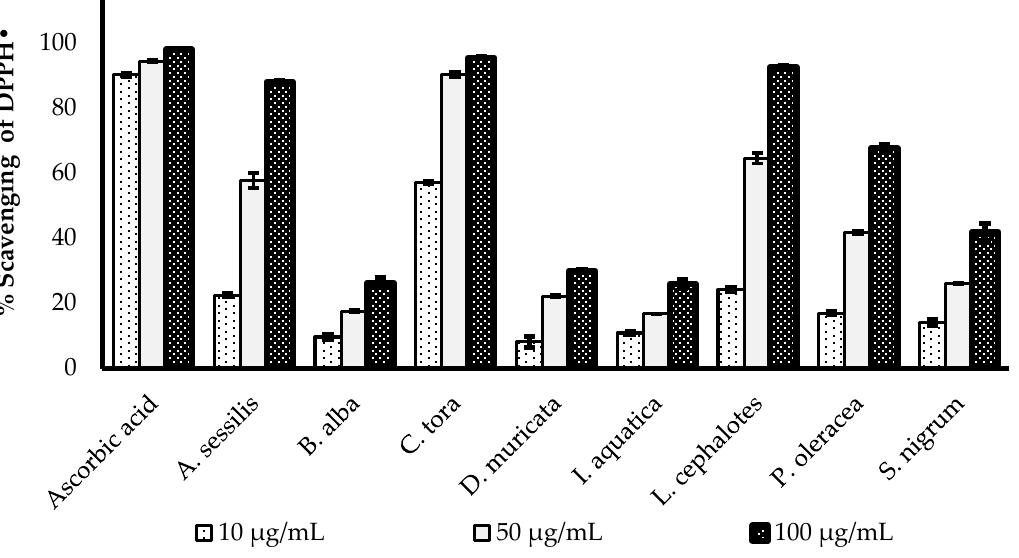
Figure 1. Comparison of DPPH • scavenging activity of ascorbic acid and selected wild leafy plants. Results expressed as the mean ± standard deviation (n = 3) at concentrations of 10, 50 and 100 µg/mL.